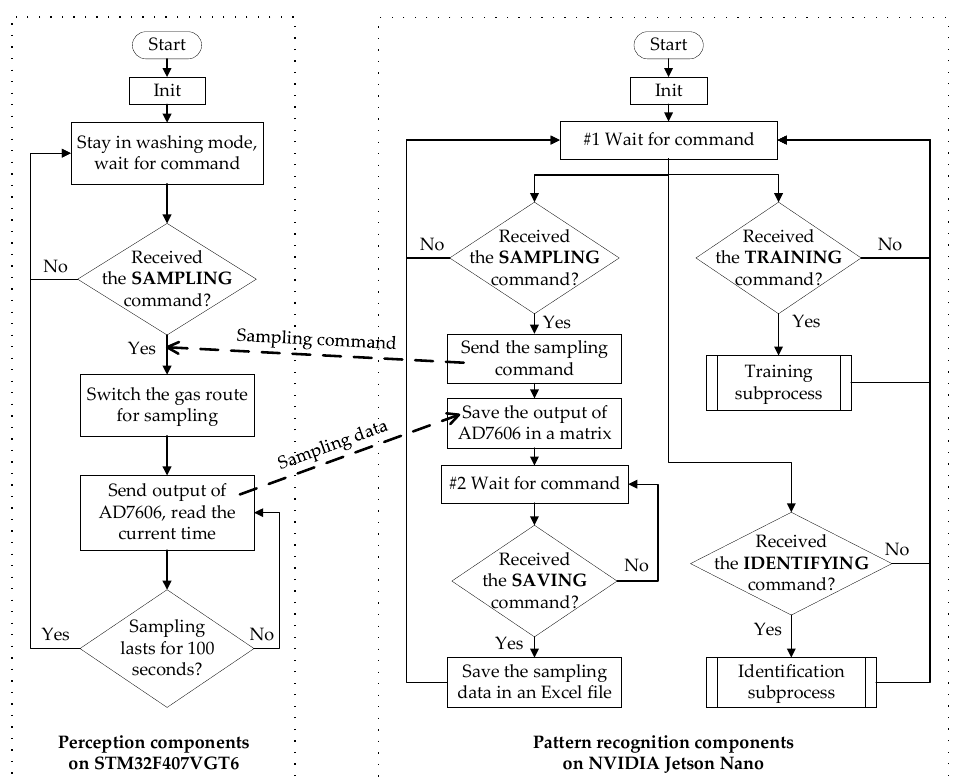
Figure 7. Flow charts of the perception and pattern recognition components. The dashed arrows stand for the interaction between the two components.